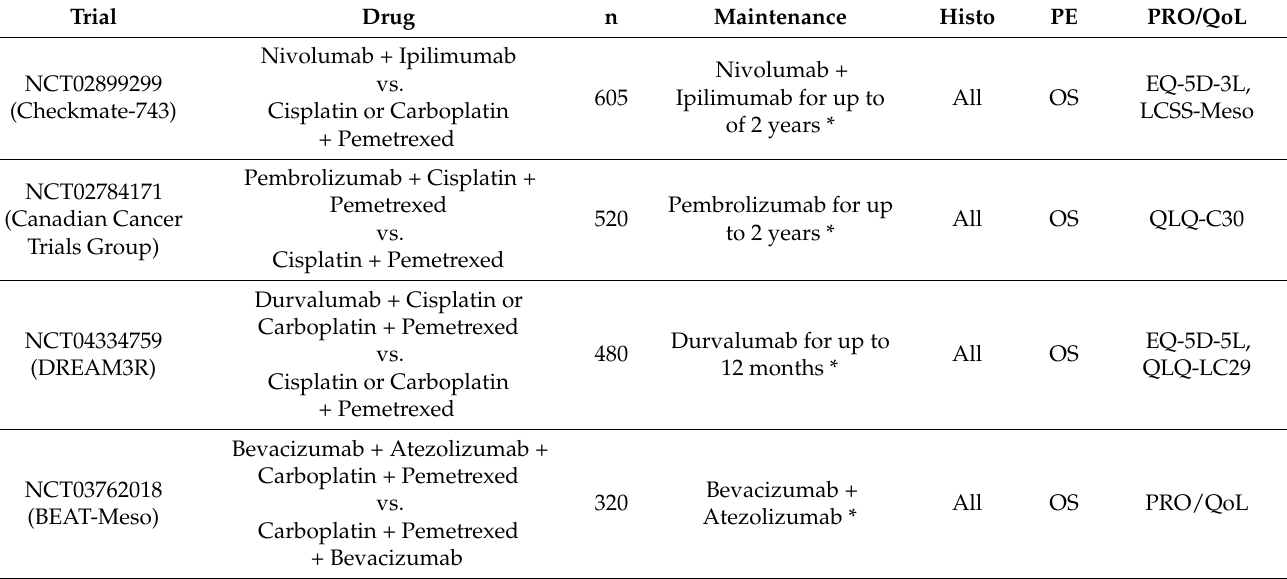
Table 1. Selected phase 3 randomized clinical trials in front-line